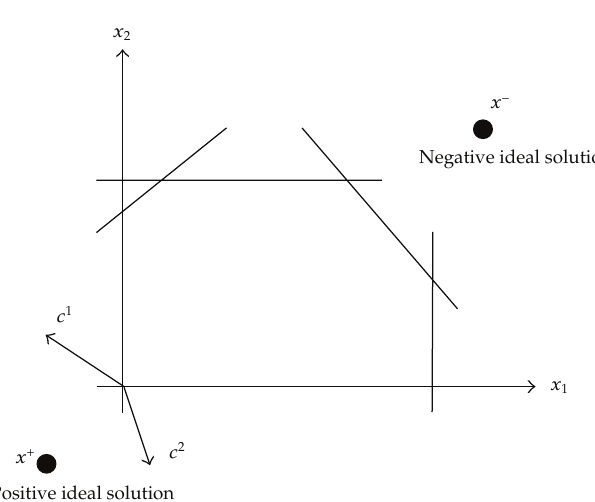
Figure 2: Positive and negative ideal solutions.